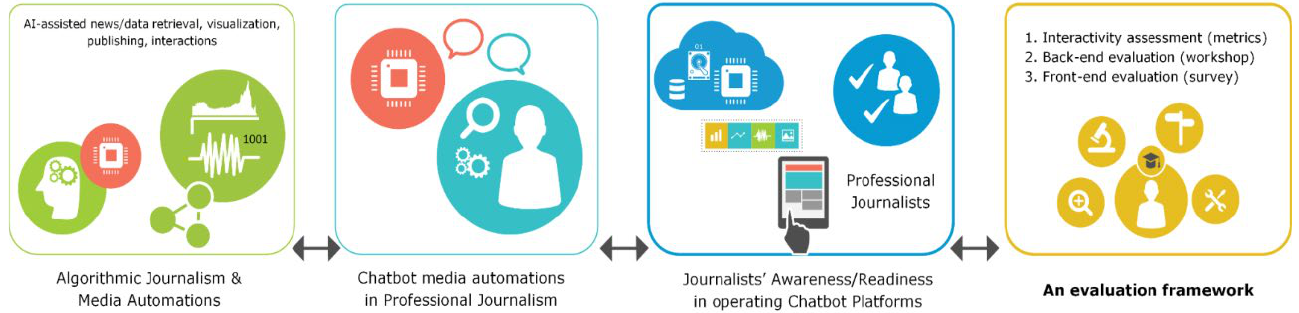
Figure 1. A conceptual diagram regarding chatbot media automation in professional journalism and the proposed evaluation framework [28].